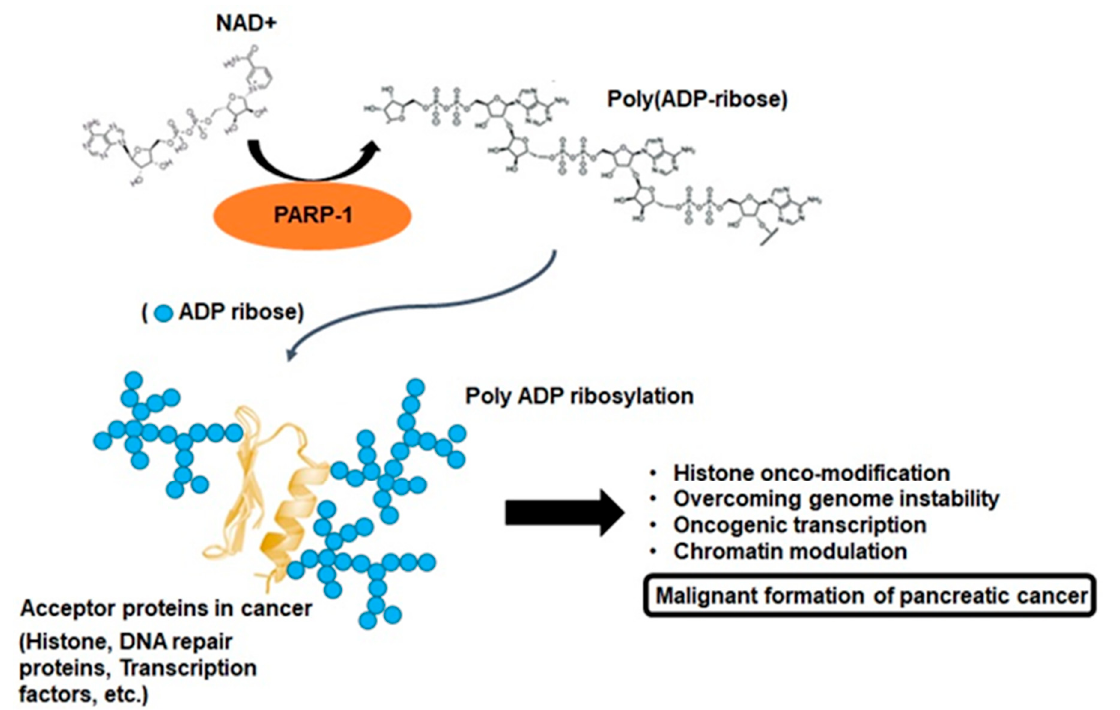
Figure 2. Poly ADP-ribosylation in cancer. PARP-1 branched poly ADP-ribose polymers following the cleavage of nicotinamide adenine dinucleotide (NAD+) to ADP-ribose. PARP-1 enables interactions by catalyzing the covalent attachment of poly ADP-ribose polymers on acceptor proteins, such as histones, DNA repair proteins, transcription factors, and chromatin modulators. This enzymology reaction is known as poly ADP-ribosylation, and this process may be important for pancreatic cancer malignant formation.